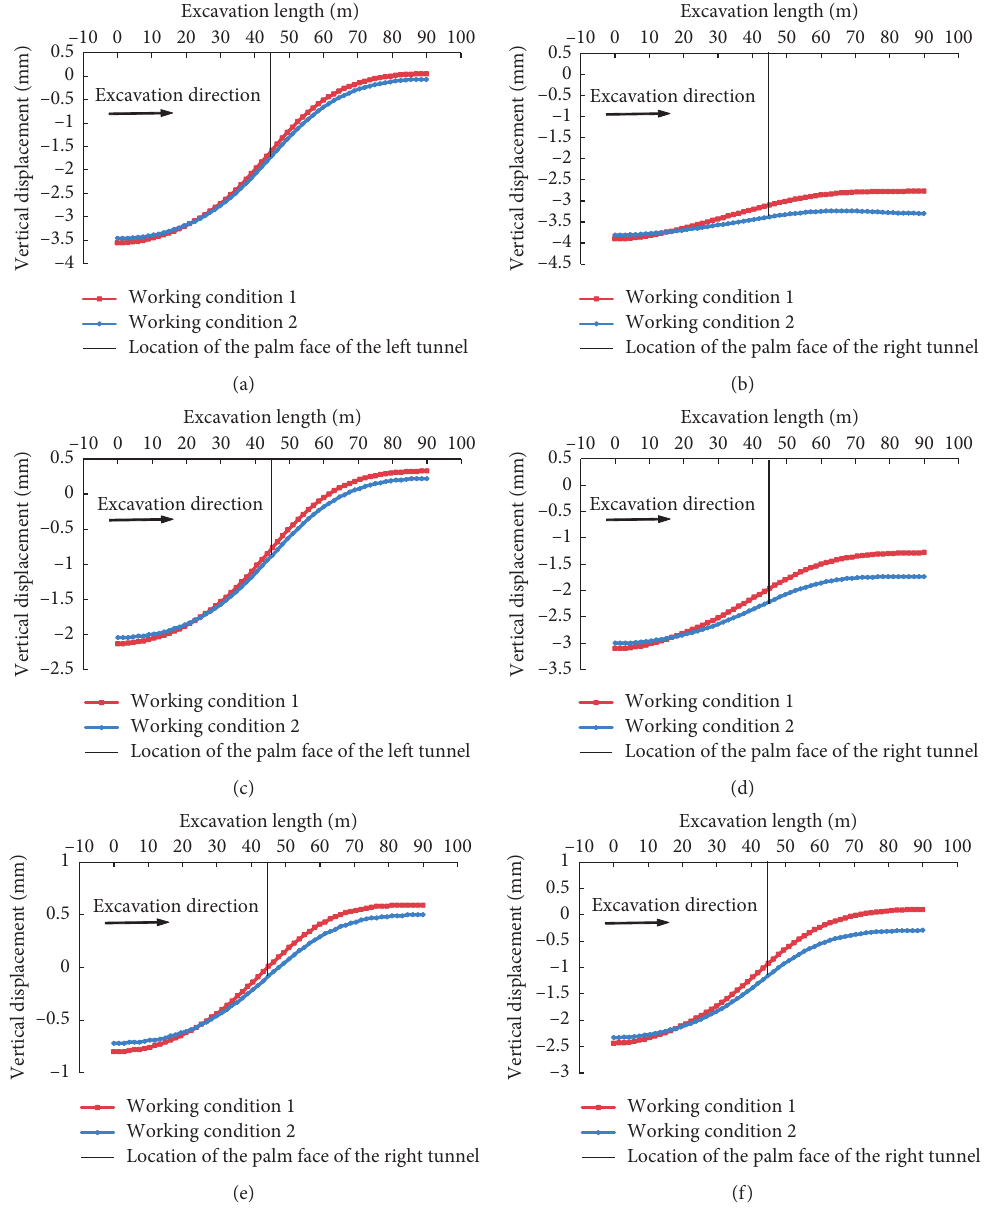
Figure 14: The vertical displacement curves of each monitoring longitudinal line in two cases at the selected moment. (a) Vertical displacement of LCB-1 when the left line is advanced to 30 rings. (b) Vertical displacement of LCB-1 when the left line is advanced to 30 rings. (c) Vertical displacement of MCB-2 when the left line is advanced to 30 rings. (d) Vertical displacement of MCB-2 when the left line is advanced to 30 rings. (e) Vertical displacement of RCB-3 when the left line is advanced to 30 rings. (f) Vertical displacement of RCB-3 when the left line is advanced to 30